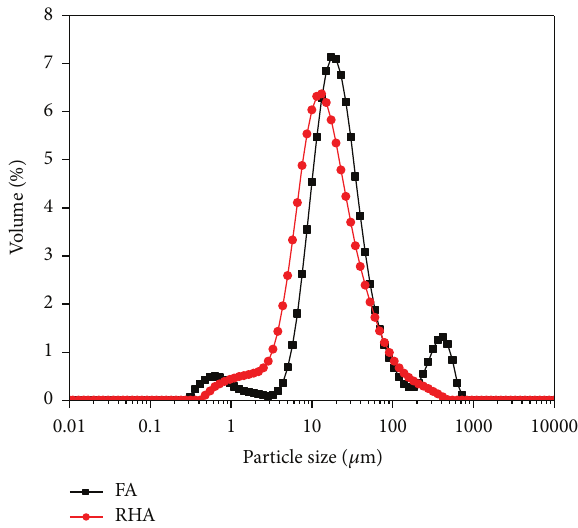
Figure 1: Particle size distributions of FA and RHA.